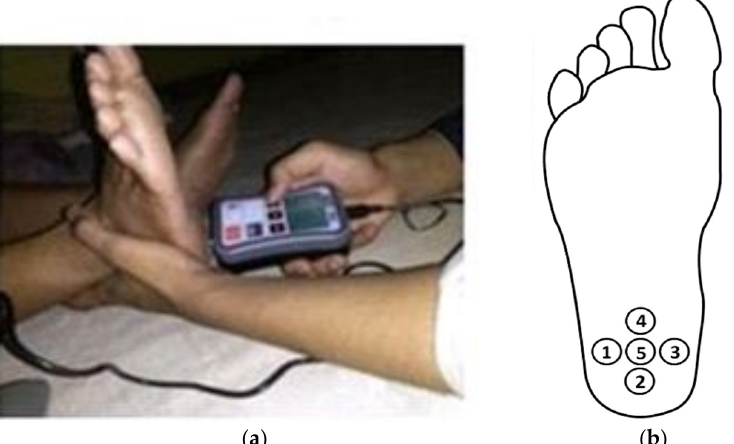
Figure 2. ( a ) Pain test in the heel region using algometer FDIX 25; ( b ) Five pain compressive points. There are five pain compressive points specified in this study. The fifth point is set at the base of the spur, the fourth point is set at the end of the spur add 1.0 cm, and another three points are set around the spur with the radius equal to spur length added with